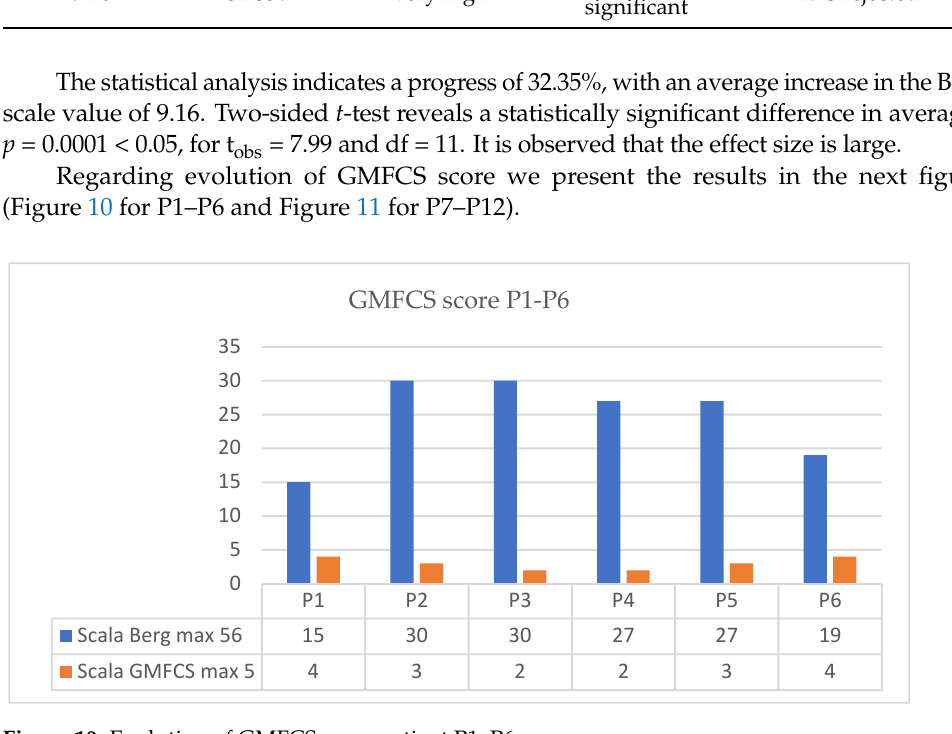
Figure 10. Evolution of GMFCS score patient P1–P6.